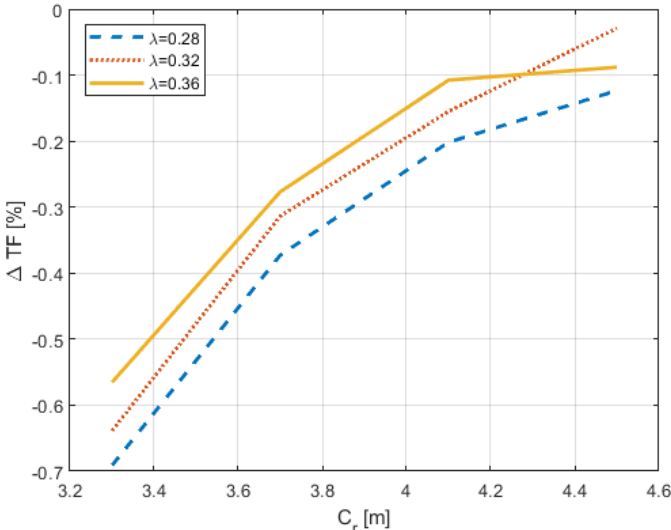
Figure 8. Fuel consumption variation with respect to the reference aircraft for the design route as a function of the taper ratio and root chord along the new feasible design space determined by intersecting the active constraints.